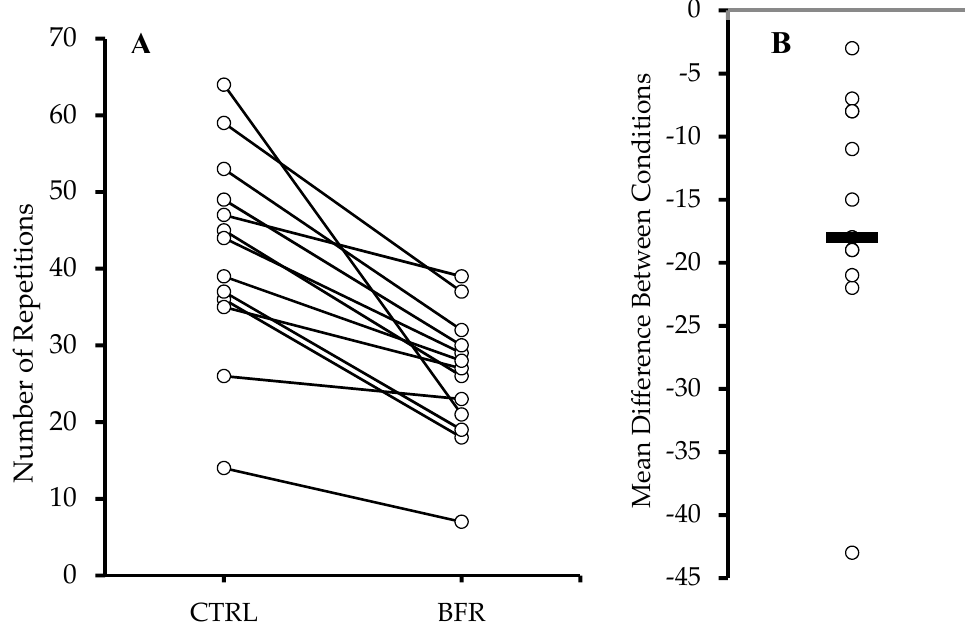
Figure 1. Total repetitions across all sets ( A ). Circles and connected lines represent individual responses. Mean difference between conditions (BFR − CTRL) ( B ). Circles and bar represent individual and group mean differences,